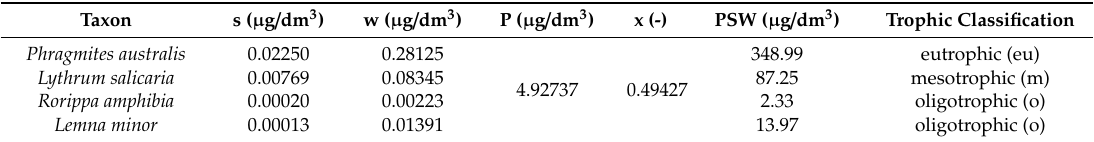
Table 13. Summary of the TIM results, May 2017, section above the small hydropower plant (SHP) on the